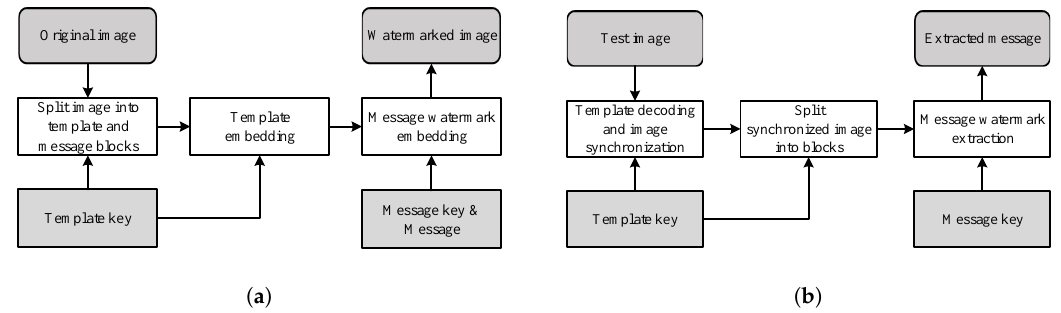
Figure 4. Watermarking process overview. ( a ) Embedding process; ( b ) extraction process.